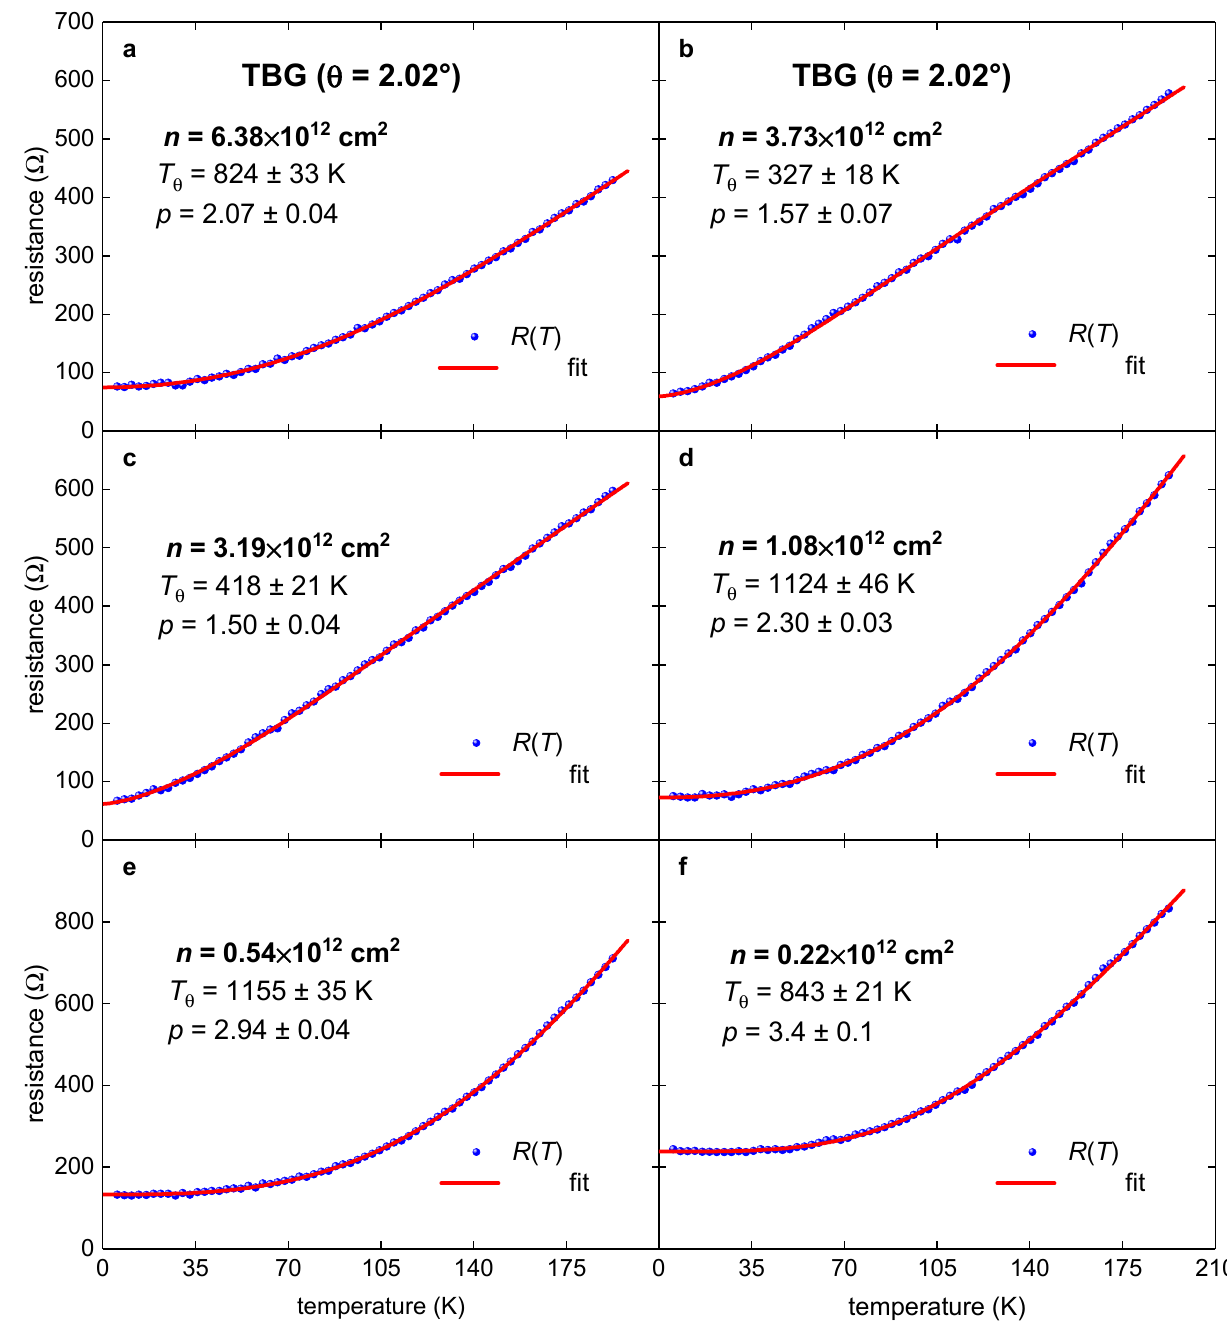
Figure 6. R ( T ) data and data fit to Equation (7) for metallic TBG superlattice on electron doping side with θ = 2.02° (raw R ( T ) data were reported by Polshyn et al. [8]). The doping state, n , for this TBG superlattice gradually varies from n = 6.38 · 10 12 cm − 2 ( a ) to n = 0.22 · 10 12 cm − 2 ( f ). Red are the fitting curves; 95% confidence bands are shown by a pink shaded area. Goodness of fit for both plots is better than R = 0.9990.